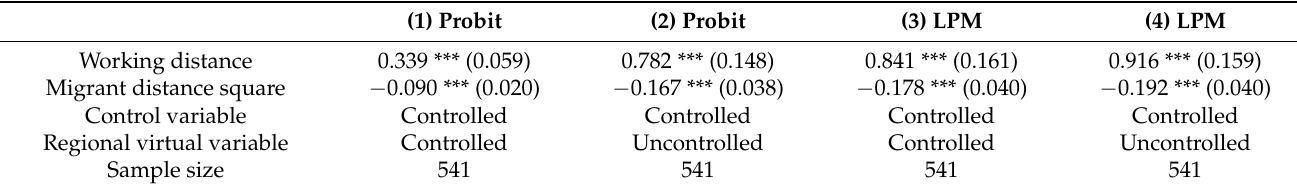
Table 5. Analysis of the impact of labour distance on farmers’ access to productive agricultural services.